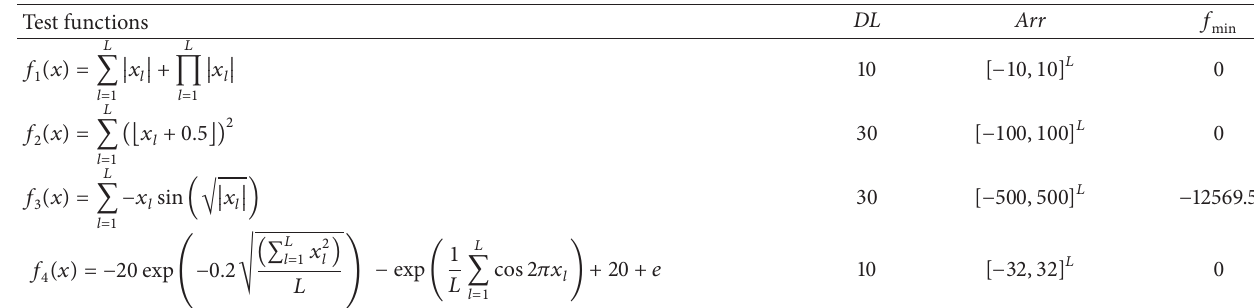
Table 1: Four benchmark functions.